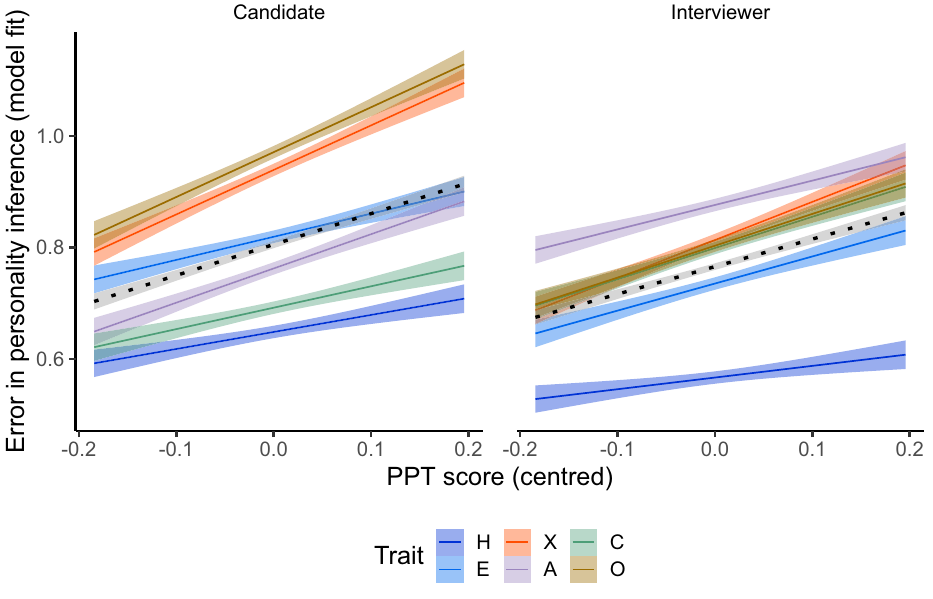
Figure 5. Plot illustrating the model estimates for the relationship between Mind-space accuracy on the PPT and trait inference error on the Interview Task. The graph shows the relationship between centred PPT error score (negative values indicate less error, i.e., better Mind-space accuracy) and trait estimate error for each trait and Target. The black dotted line represents the overall effect for that Target, regardless of trait. Shaded areas show standard